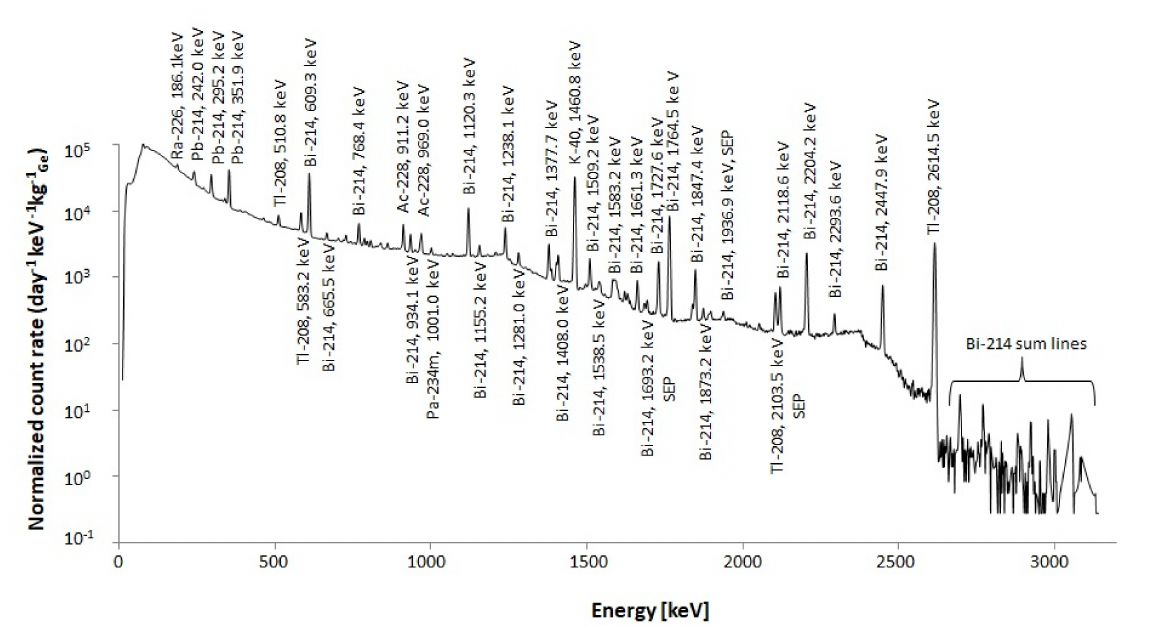
Figure 3. Gamma ray spectrum registered in situ in excavation No. 3 near SW-1 shaft. The main visible peaks are identified. Table 1. Integral count rates in the energy range of 7–2734 keV in several underground sites studied with the use of in situ HPGe